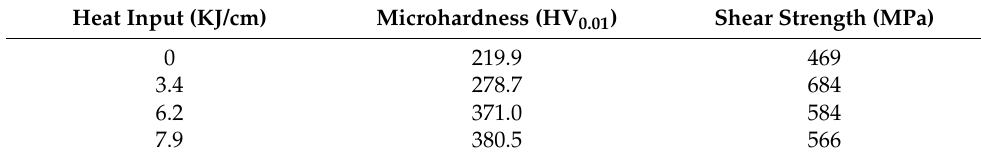
Table 4. Microhardness (HV 0.01 ) of Bonding Phase and Shear strength (MPa) of the Specimens. Heat Input